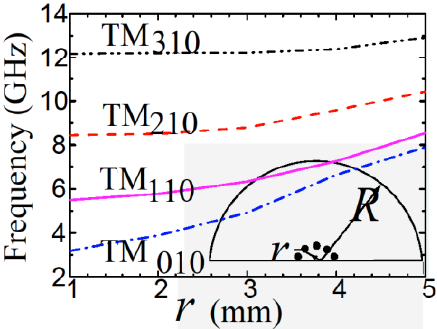
Figure 6. Variations of resonant frequencies with parameter r .